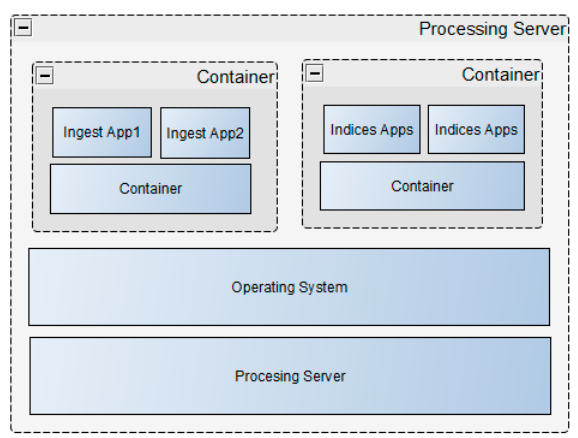
Figure 11. Application deployment, scaling and management are based on Kubernetes. Applications are hosted in containers that can easily be scaled up. Applications also support multi-threads.